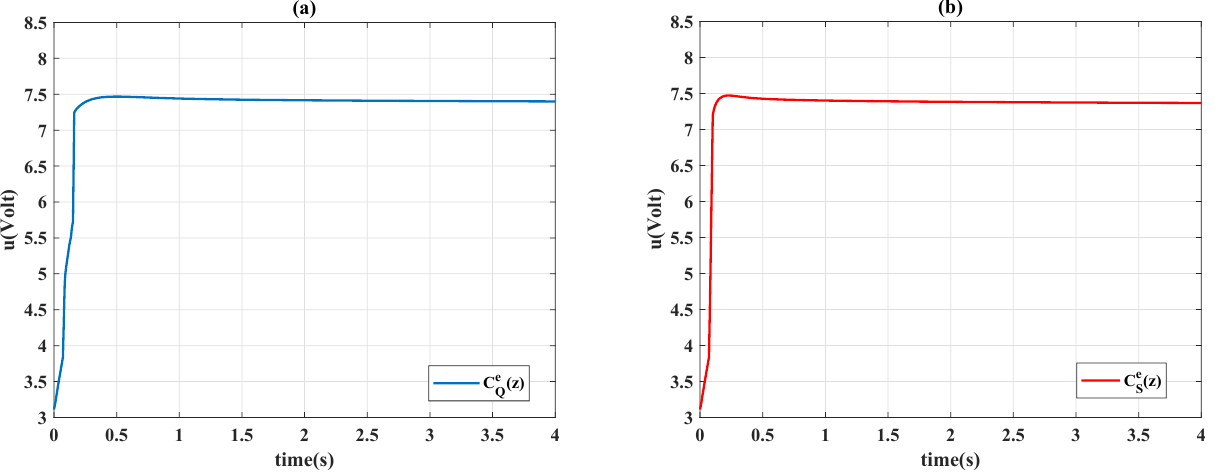
( z ) ; ( b ) Sarsa C e ( z ) Q S